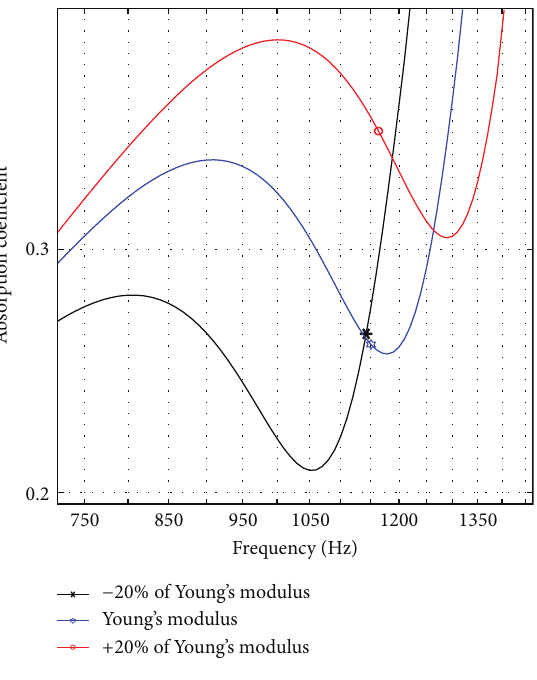
Figure 4: 𝐸 effects on absorption coefficient. Figure 5: The zoom around of 𝑓 𝑟 .